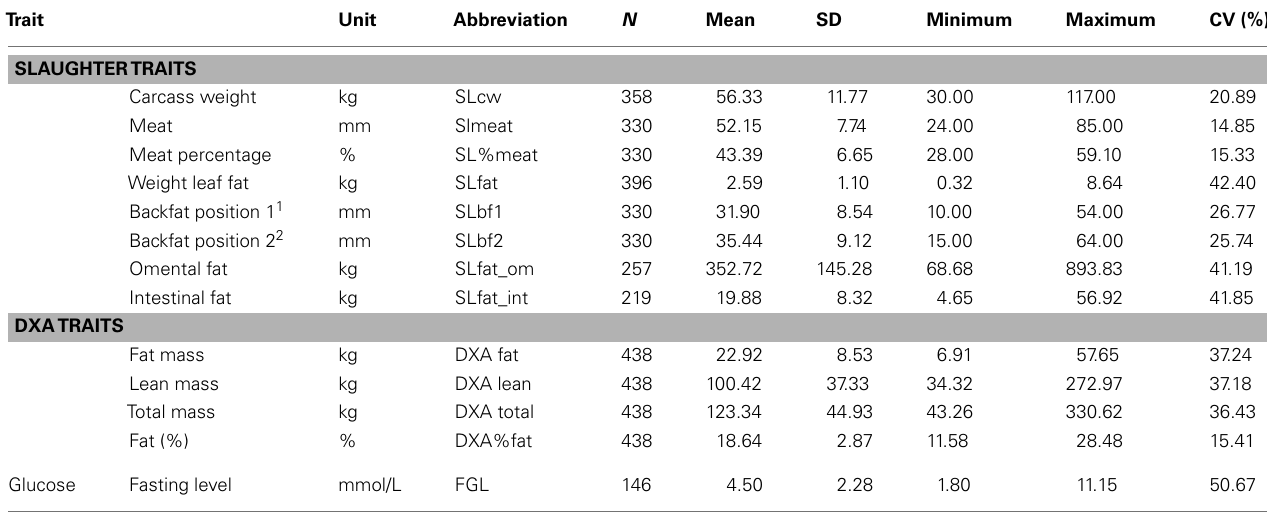
Table 1 | Summary of all traits directly associated with obesity and obesity-related traits (mean, range, and SD) with their abbreviations.